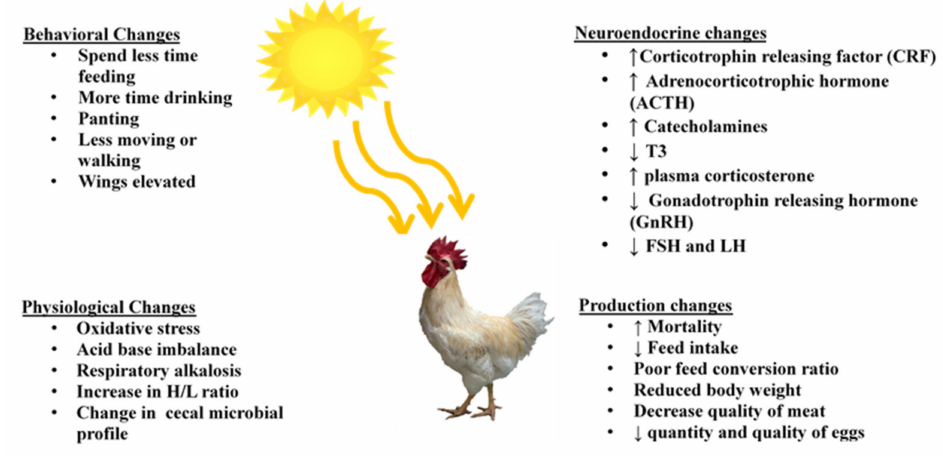
Figure 1. E ff ects of heat stress on behavioral, physiological, neuroendocrine, and production